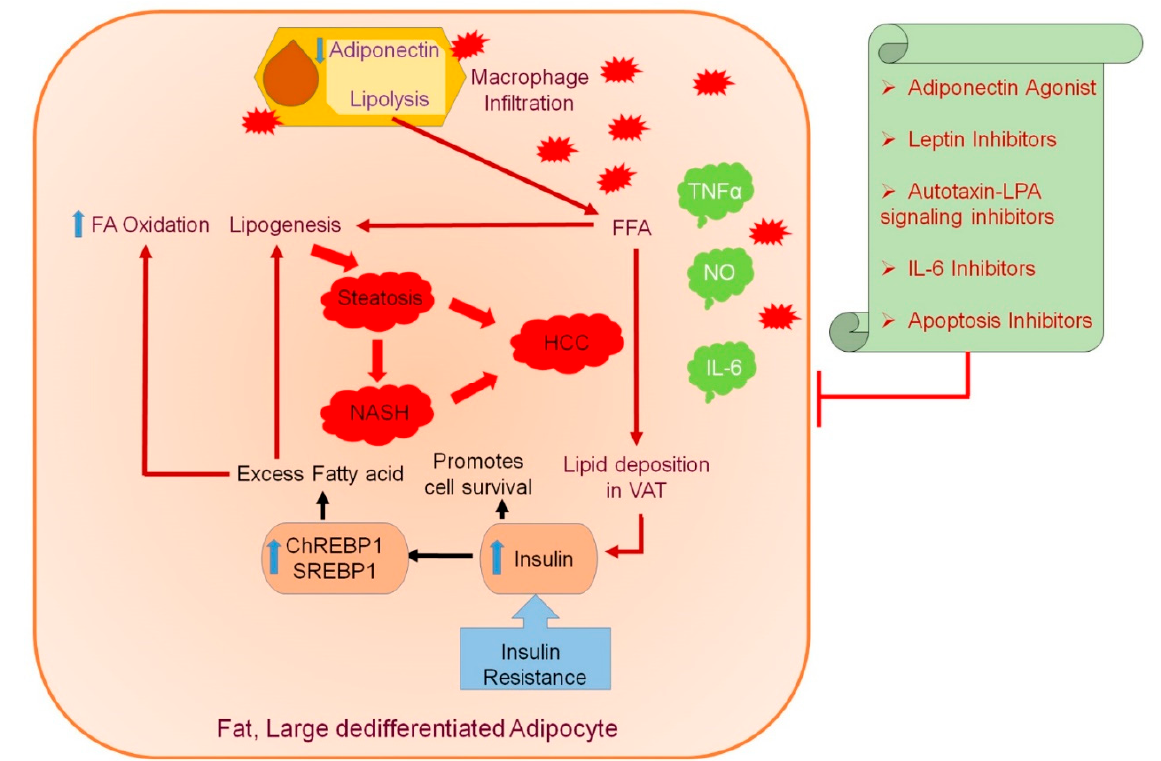
Figure 2. Correlation between adipose tissue and adipokines with the development of obesity-induced hepatocellular carcinoma (HCC) and the effect of adiponectin agonists and other inhibitors. The adipose tissue (AT) secretes various bioactive peptides, known as adipokines, and their associated dysregulation has been implicated in metabolic disorders caused by obesity. The swollen and dedifferentiated adipocytes secrete less adiponectin (ADP) during obesity, and ADP is the only adipokine of which the circulating levels are significantly reduced during obesity. In muscles and the liver, ADP increases insulin action and exerts an antiatherogenic effect. Leptin is another adipokine that regulates energy balance and exerts an insulin-sensitizing effect, but its beneficial effects are reduced in obesity due to leptin resistance. In obese individuals, an inflammatory state is contributed through macrophage infiltration due to excessive production of TNF α , IL-6, or resistin deteriorating insulin action in the liver. Increased lipolysis secretes FAs that accumulate triglyceride in visceral adipose tissue (VAT) in correlation with insulin resistance (IR). The IR and elevated FFAs predispose to steatosis, promoting hepatic lipogenesis and increasing SREBP1 and ChREBP1 expression, further promoting damage to liver tissues and a state of inflammatory response, resulting in NASH followed by HCC. The inflammatory response promoted by obese AT contributes to damage of hepatic cells and impaired immune response. The administration of ADP agonists and AT targeting inhibitors might be a promising therapeutic target for adipokine-mediated obesity-induced HCC. Blue upward arrow indicates an increase and blue downward arrow indicates a decrease.